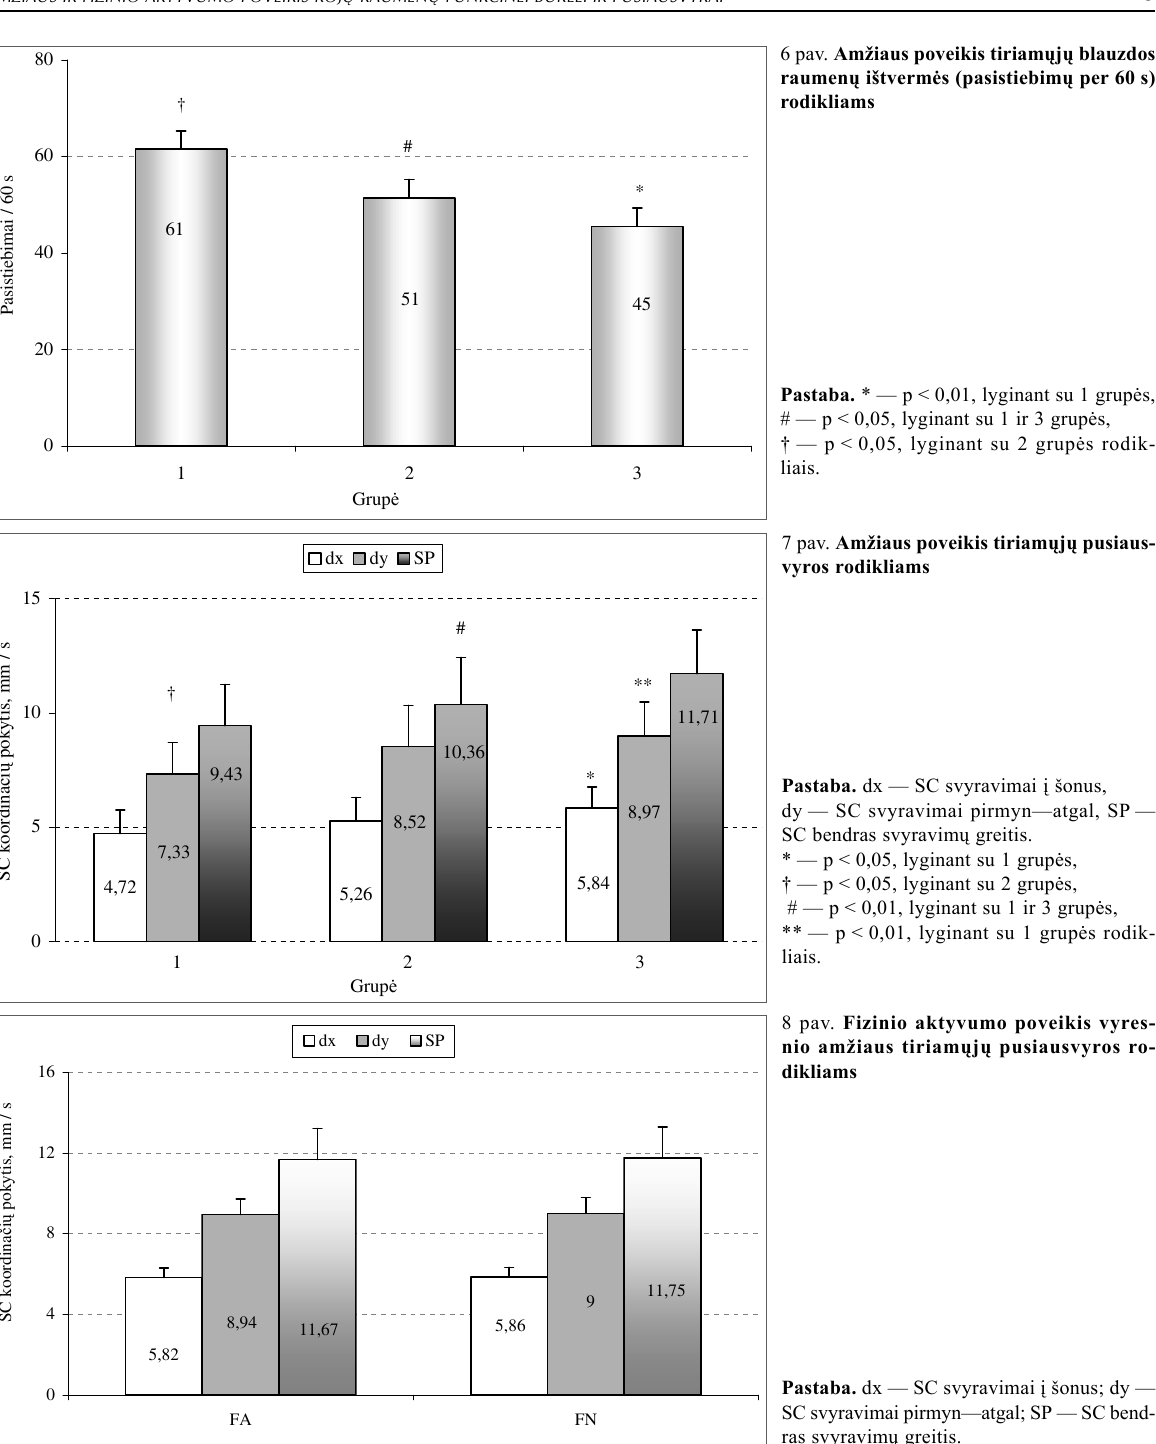
metu tirtos vyresnio amžiaus moterys, geban č ios pasir ū pinti savimi ir gyvenan č ios savarankiškai.